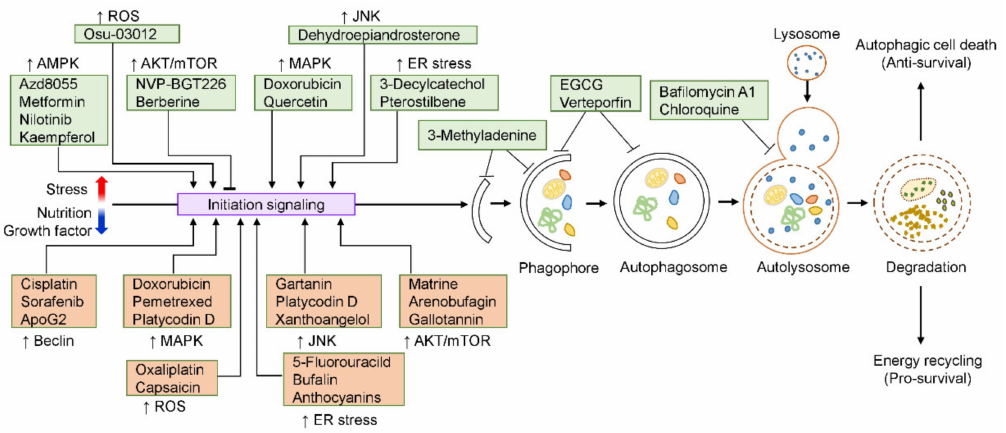
Figure 2. Representative autophagy-modulating small molecules in HCC. Diverse small molecules can modulate autophagy in HCC at di ff erent steps. Small molecules capable of activating ( ↑ ) or inhibiting ( ↓ ) autophagy through the regulation and autophagy-related signaling and process are proposed. Small molecules that a ff ect HCC cell fate by autophagy modulation are shown in green boxes (cell death) and orange boxes (cell survival). ApoG2, Apogossypolone; EGCG, (-)-Epigallocatechin-3- O -gallate; ROS, reactive oxygen species; JNK, c-Jun N-terminal kinase; ER. endoplasmic reticulum; AKT / mTOR, protein kinase B / mammalian target of rapamycin; MAPK, mitogen-activated protein